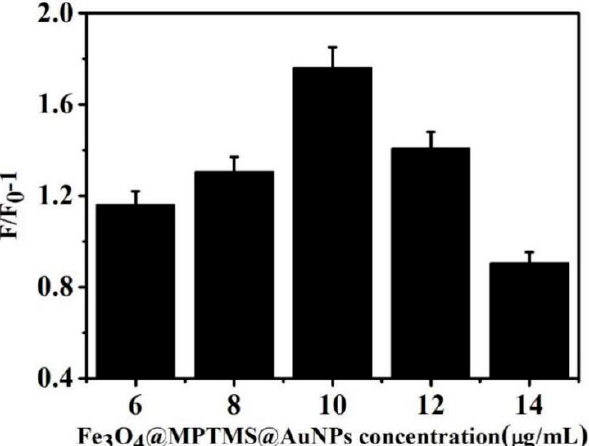
Figure 4. Effect of different concentrations Fe 3 O 4 @MPTMS@AuNPs on fluorescence intensity.